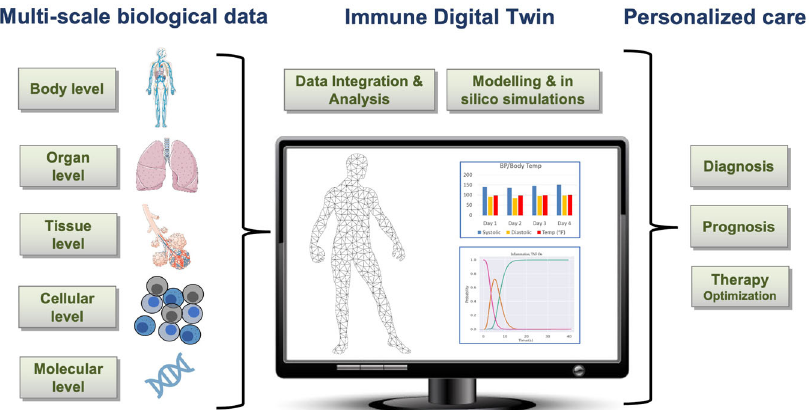
Fig. 1 The construction and use of a digital twin. At each relevant physiological scale, known biology and relevant mechanisms are characterized through data collection that informs one or more computational models. The models at the individual scales are then integrated into a comprehensive multiscale base model. In the second step, this base model is personalized by parameterizing it with data collected from an individual patient. The resulting digital twin can then be used for clinical decision-making for this patient. (The images are public domain images from Servier Medical Art (https://smart.servier.com/smart_image/tendon-anatomy/), https://all-free-download.com/ free-vector/ fl at-screen-computer-monitor.html, and https://pixabay.com/vectors/man-male-boy-human-people-persons-2099114/). All other images were produced by the authors).